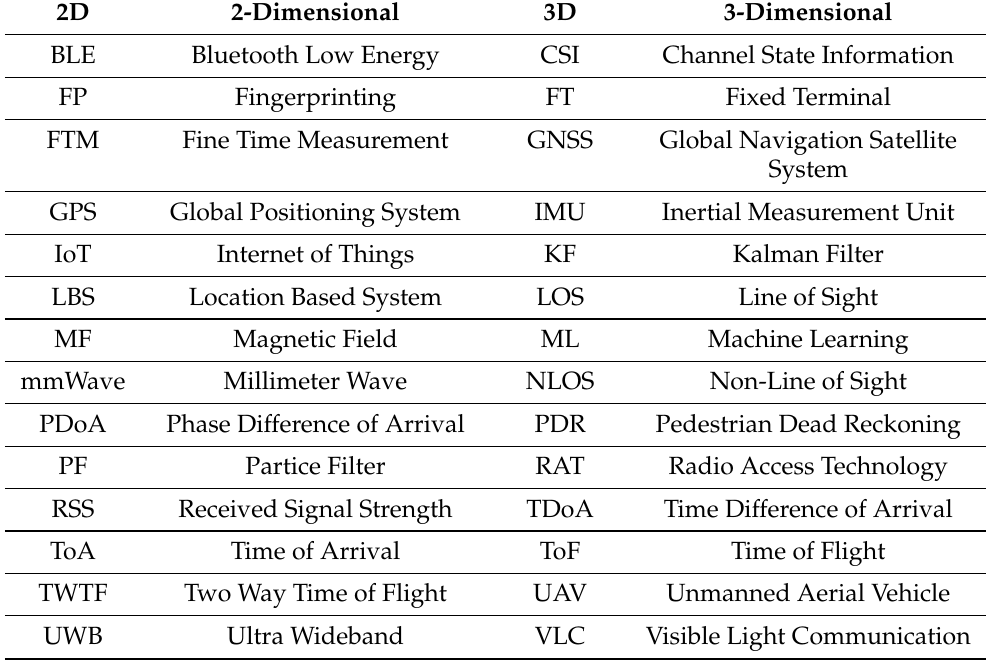
Table 1. Notations and Symbols Used Throughout the